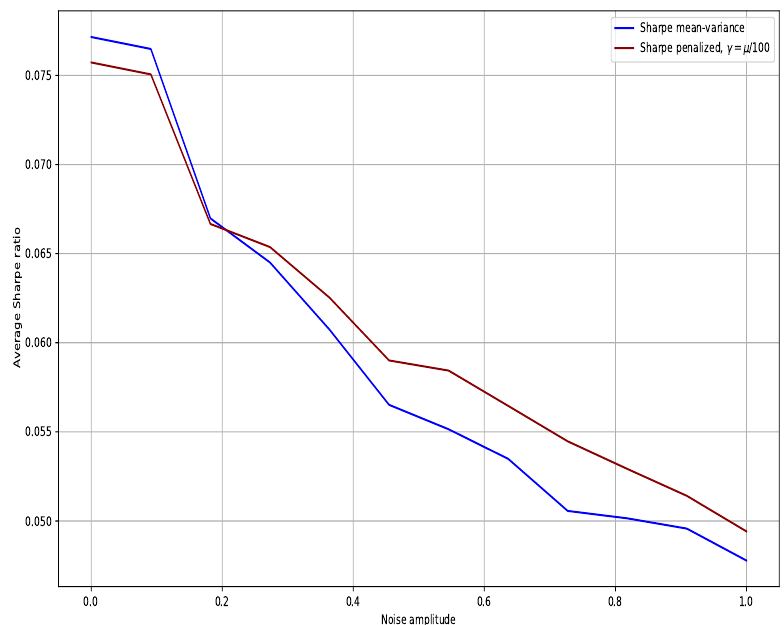
Figure 3. The highest average Sharpe ratio attained by the ERC portfolio is equal to 0.051 for (cid:101) =